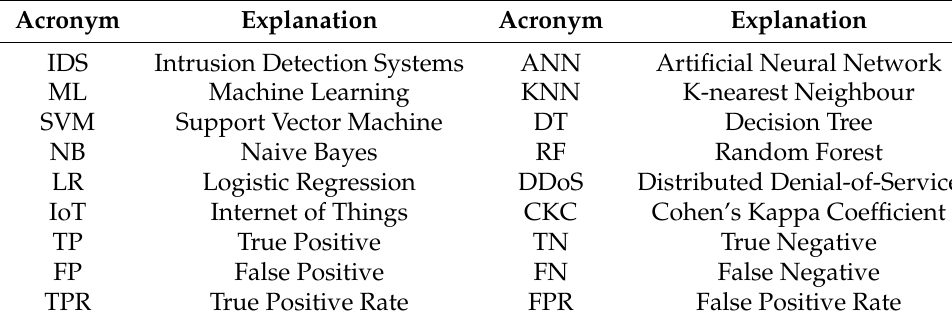
Table 1. Abbreviations and their explanations.